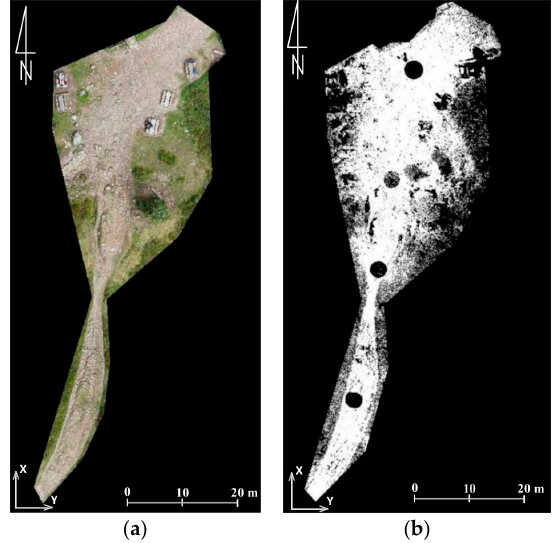
Figure 8. Point clouds from the UAV ( a ) and TLS ( b ) which represent the first test field (source: authors’ own study).